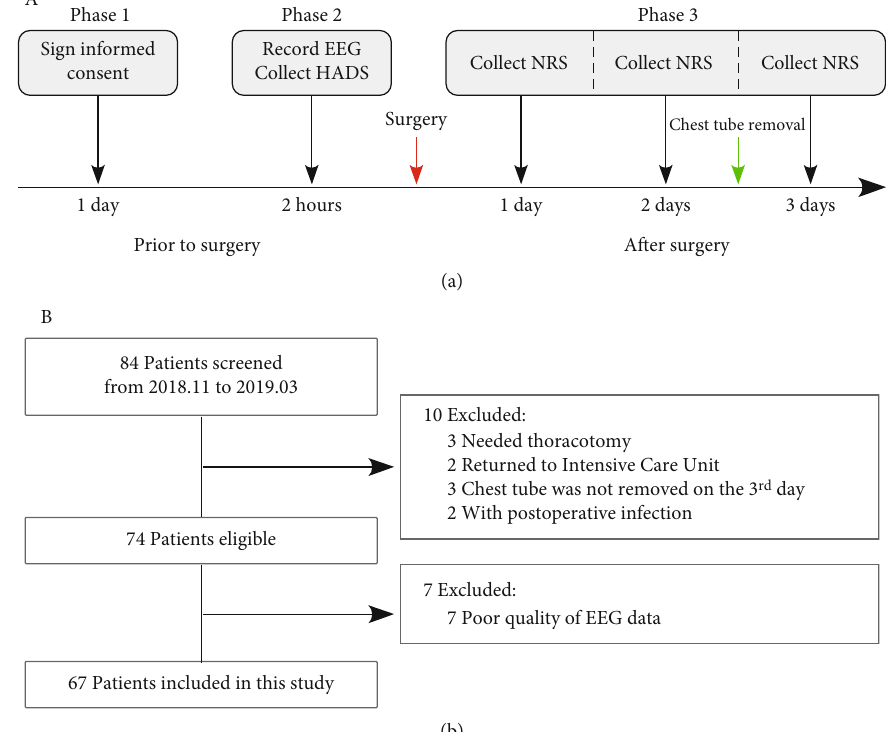
Figure 1: (a) Study design and the (b) fl ow of